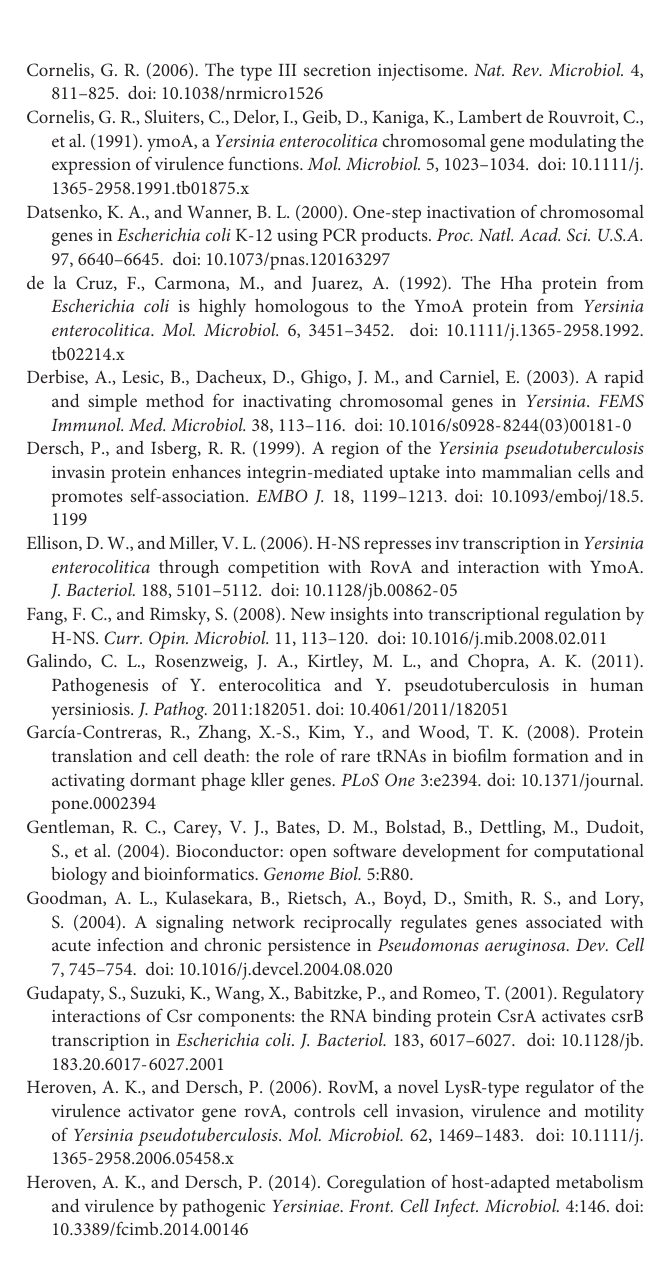
control as well as (B) the yscW-lcrF promoter fragment and a csiD fragment of E. coli serving as negative control were incubated without or with increasing amounts of purified Y. pseudotuberculosis YmoA in the presence or absence of H-NS or H-NS alone. The samples were separated on 8% polyacrylamide gels. The positions of the gene fragments are indicated, and the formation of higher molecular complexes is shown by an arrow. Supplementary Figure 8 | Temperature-dependent YmoA degradation. Whole cell extracts from overnight cultures of Y. pseudotuberculosis strains YPIII (wild-type), YP63 ( (cid:49) clpP ), YP64 ( (cid:49) lon ) and YP67 ( (cid:49) clpP (cid:49) lon ) grown in LB at 25 and 37 ◦ C were prepared, separated by 20% TRICINE-PAGE and analyzed by Western blotting using a polyclonal anti-YmoA antibody. Whole cell extract of an overnight culture of YP50 ( (cid:49) ymoA ) was used as negative control. A molecular weight marker was loaded on the left, the YmoA protein is indicated by an arrow. Unspecifically detected proteins (c) were used as loading